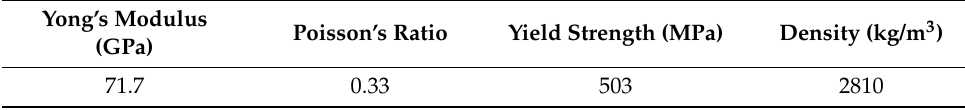
Table 2. The material parameters of Al7075